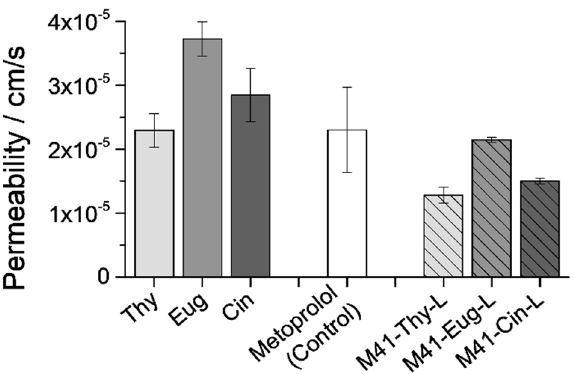
Figure 8. Apical to basolateral permeability (P ab ) values obtained from the intestinal membrane treatment with the three different EOCs, both free (solid bars) or encapsulated into the M41-EOC-L microdevices (striped bars). Metoprolol’s permeability values were also added as standard perme- ability reference (white bar). Provided data represent the average of three different experiments measured in triplicate, and the error bars represent the standard